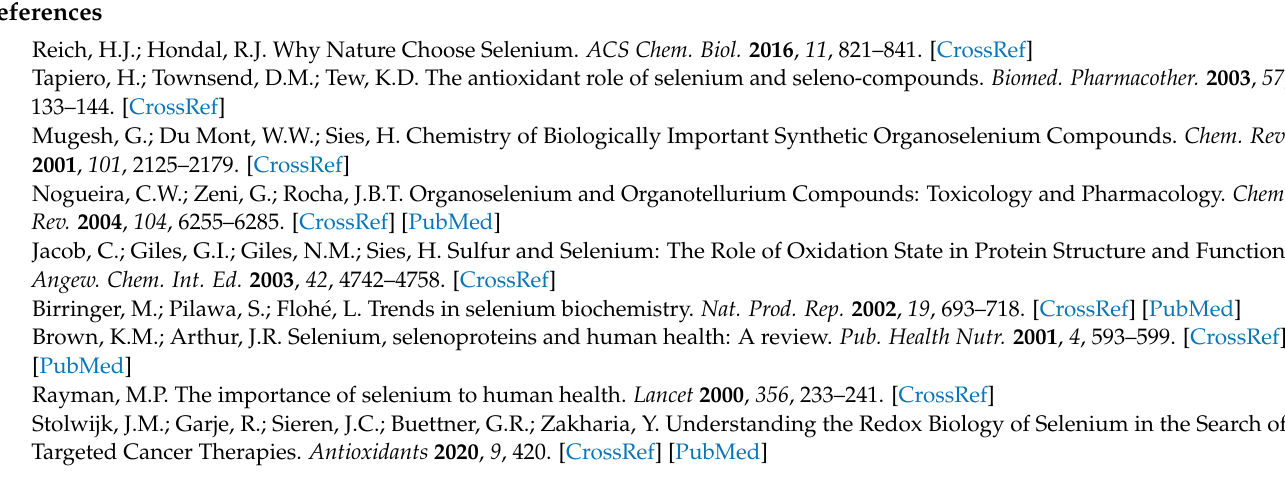
Figure S3: Absorption spectra of 2-SeU recorded in deaerated aqueous solutions at various pHs; Figure S4: Solution phase (PCM) optimized geometries of monomer-type transients expected to be formed in solutions at pH 4; Figure S5: Solution phase (PCM) optimized geometries of